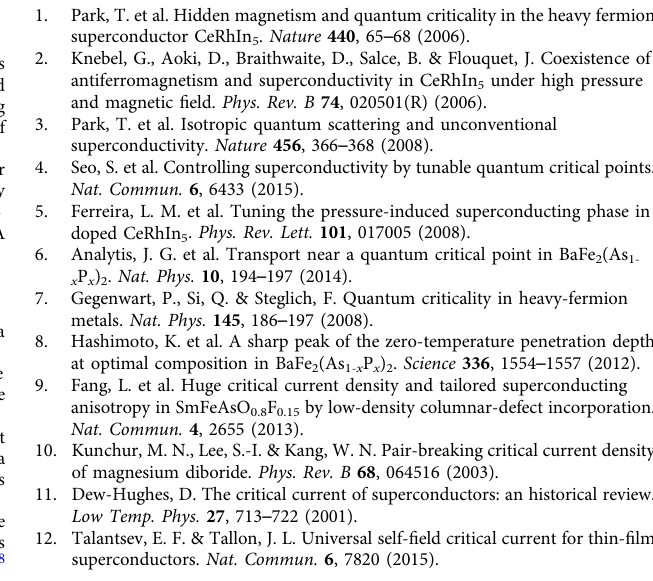
Fig. 3 Pressure evolution of the zero- fi eld critical current in Sn-doped CeRhIn 5 . a Pressure dependences of T c,0 and I c,0 for SnRh115, where I c,0 is the value of I c obtained from an extrapolation of data in Fig. 2b zero Kelvin. b Fractional variations in as γ I (at 0 K) ≡ I c,0 ( P )/ I c,0 ( P c ) × 100 and γ T ≡ T c,0 ( P )/ T c,0 ( P c ) × 100, where I c,0 ( P c ) is I c extrapolated to zero temperature at P c and T c,0 ( P c ) is